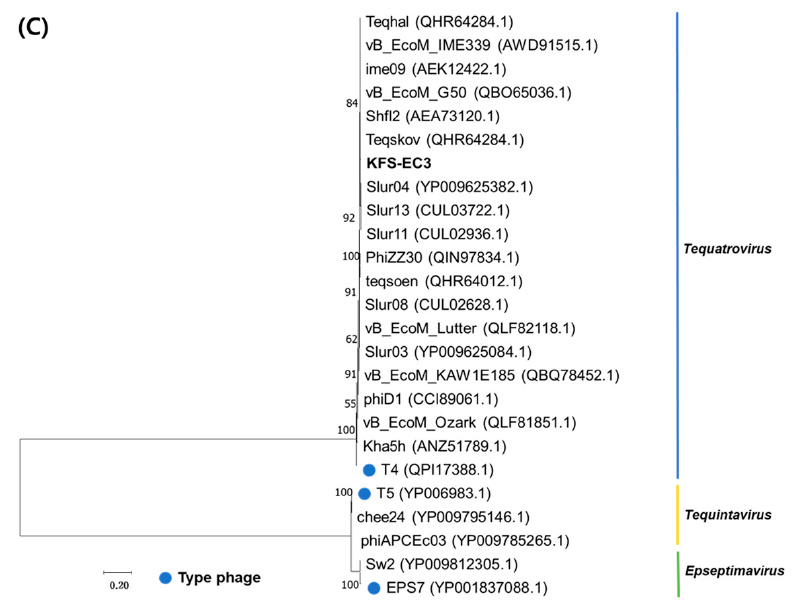
Figure 6. Phylogenic analysis of KFS-EC3 and other related phages based on the ( A ) complete genomes, ( B ) capsid protein, and ( C ) terminase large subunit.